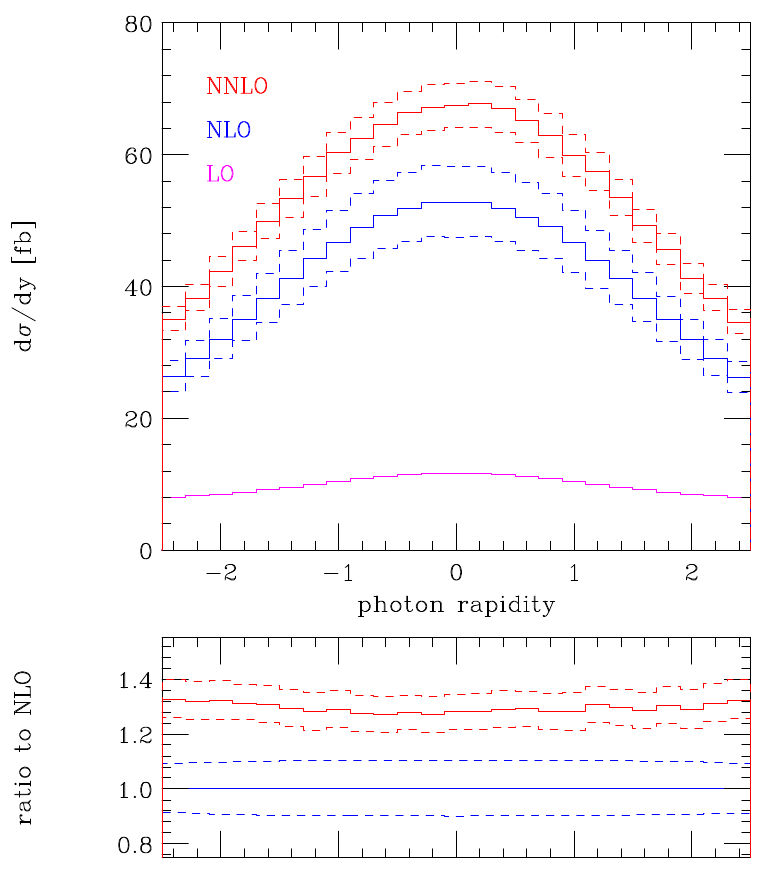
Figure 5 . Distribution of the photon rapidity at 13 TeV. The NNLO and NLO histograms display the error estimates, obtained via a 9-point scale variation, and the lower panel displays the ratio of the NLO and NNLO predictions to the central NLO